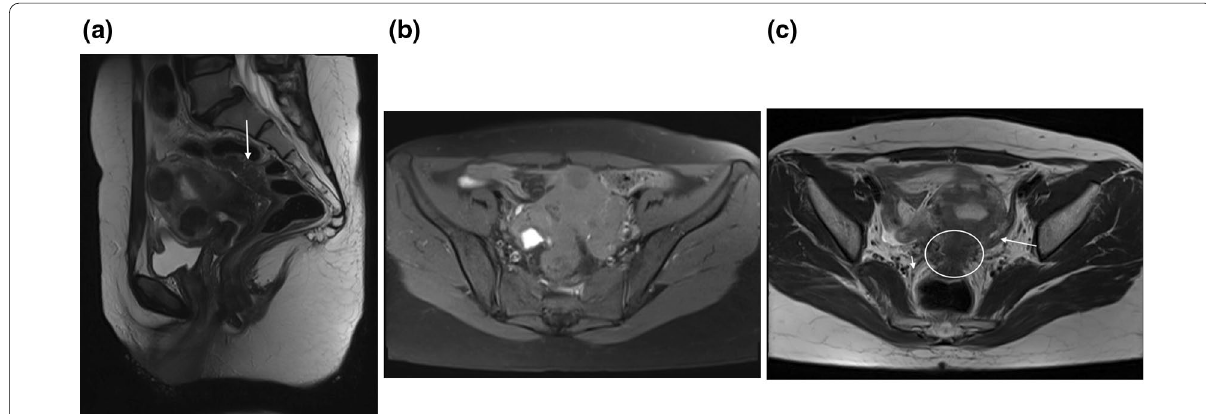
Fig. 5 a T2 weighted sagittal MRI image showed large hyposignal plaque of DIE involving the rectum. b T1 weighted axial fat-suppressed image in the same patient shows hypersignal typical endometrioma in the right ovary. c T2 weighted axial MRI image showed obliteration of posterior cul-de-sac, DIE in retrocervical and rectal wall, uterosacral (small arrow) and round ligaments (large arrow) with adhesions